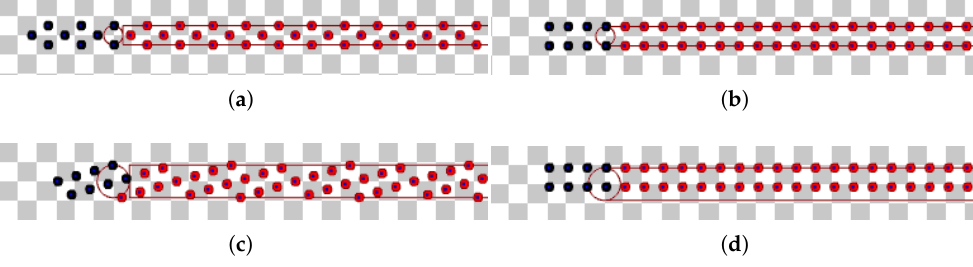
Figure 44. Screenshots of the Stage simulation for hexagonal packing and parallel lanes strategy for d = 1 m and s ∈ { 0.5,0.85 } m. ( a ) Hexagonal packing with best θ for s = 0.5 m.